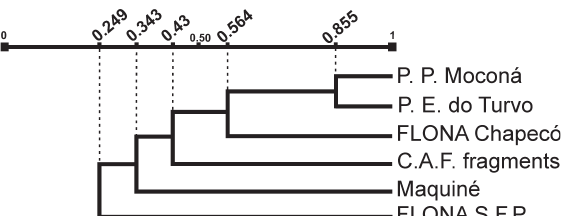
Figure 5 - Dendrogram resulting from cluster analysis with UPGMA method using the Abundance-based Jaccard estimator of Pentatomidae